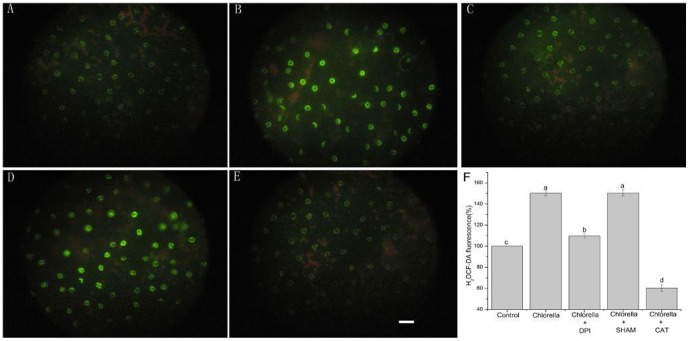
Chlorella induces ROS production in V. faba.Epidermal peels of broad beans without (control) (A) or with 120 min of treatment with Chlorella alone (B), with Chlorella and DPI (C), with Chlorella and SHAM (D) or with Chlorella and CAT (E) were loaded with 50 µM of H2DCF-DA for 15–20 min in the dark. After a brief wash with opening buffer, photographs were taken for representative pairs of guard cells from each treatment using fluorescence microscopy (A–E). The scale bar in E is 100 µm, and applies to all photographs. (F)The average fluorescence intensity of guard cells in images (A–E). The vertical scale represents percentage response relative to fluorescence value taken as 100% in control treatments. These data are the mean ± SE of the representative results from three biological repeats (100 total guard cells per bar). Different letters above the bars indicate mean values that are significantly different from one another as determined by ANOVA (LSD test, P<0.05).